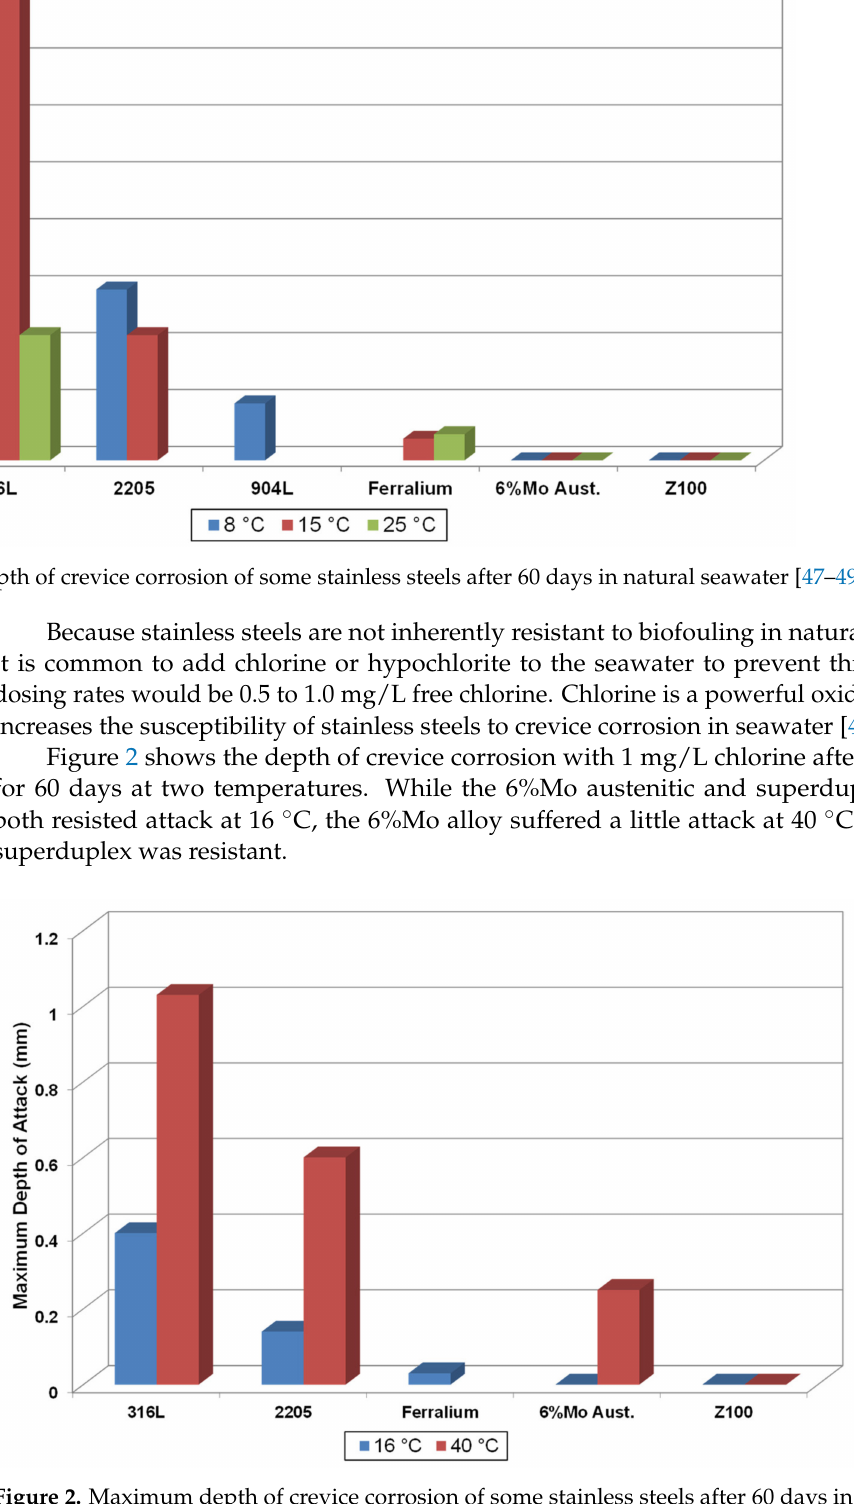
Figure 2. Maximum depth of crevice corrosion of some stainless steels after 60 days in chlorinated (1 mg/L) seawater. Adapted from [45]. At the time of writing superduplex is preferred to 6%Mo austenitic because of its lower cost, due to the lower nickel and molybdenum